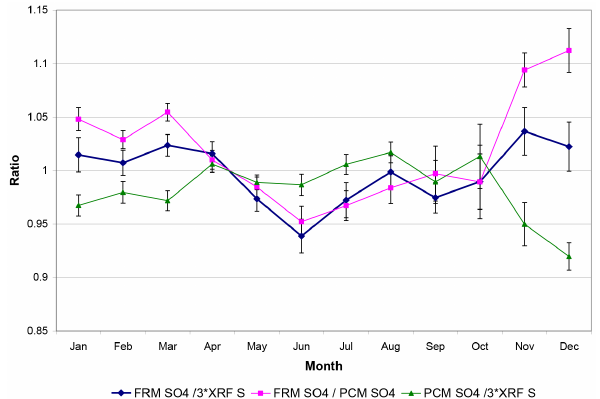
Figure 4. Comparison of the US federal reference method (FRM) SO 4 , FRM X-ray fluorescence S (multiplied by 3 to represent SO 4 ), and ARA-SEARCH sampler (PCM1) SO 4 . The data are from JST, 1999 and 2000 (19–54 days per monthly mean). The PCM1 sampler is configured with a denuder to remove SO 2 and thereby reduce or eliminate positive artifacts, whereas the FRM sampler is not. FRM SO 4 measurements at other sites and during other years were too limited for comparison ( n < 4 values per month except at BHM, where n = 8–11 values during 6 months). XRF S measurements are made on FRM filters.